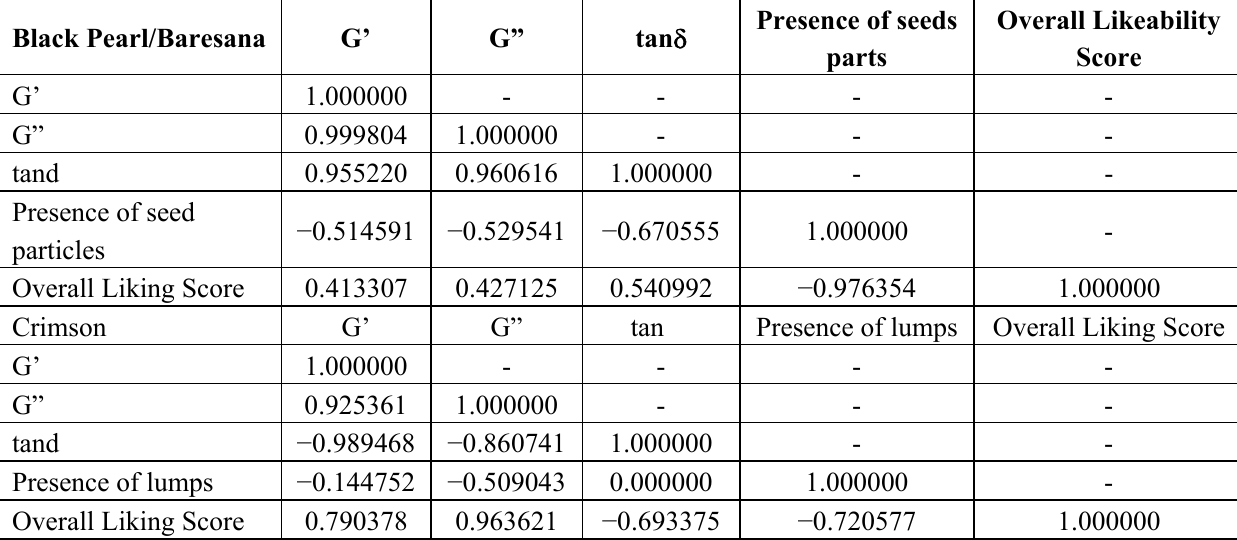
Table 3. Correlation results between sensorial attributes and rheological parameters of the functional table grape-based